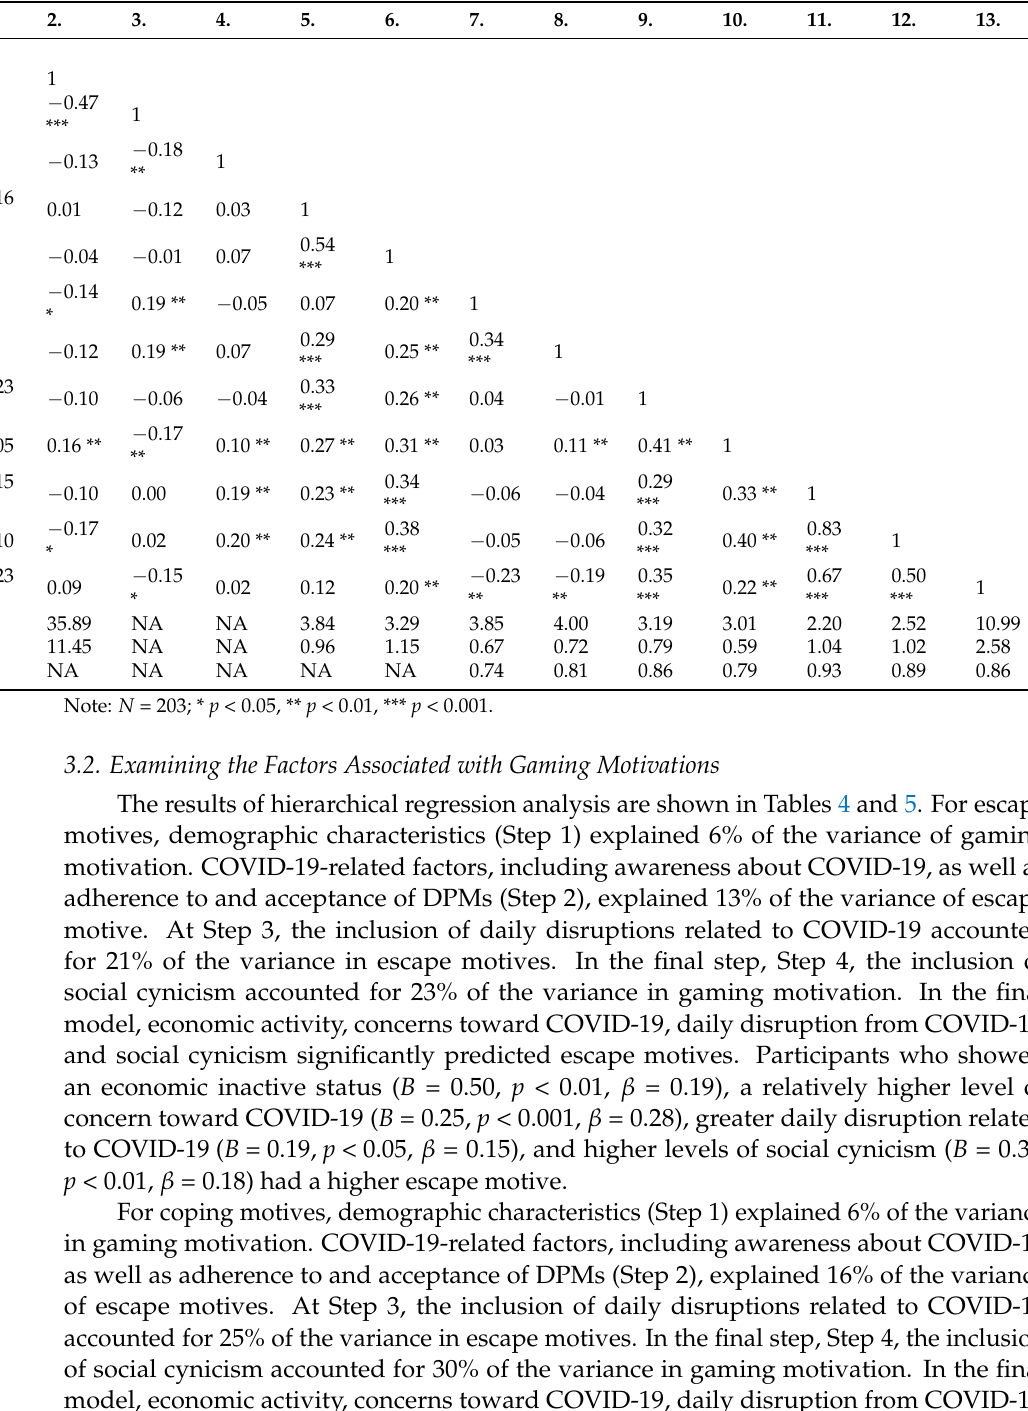
Table 3. The Correlation Matrix of the Study